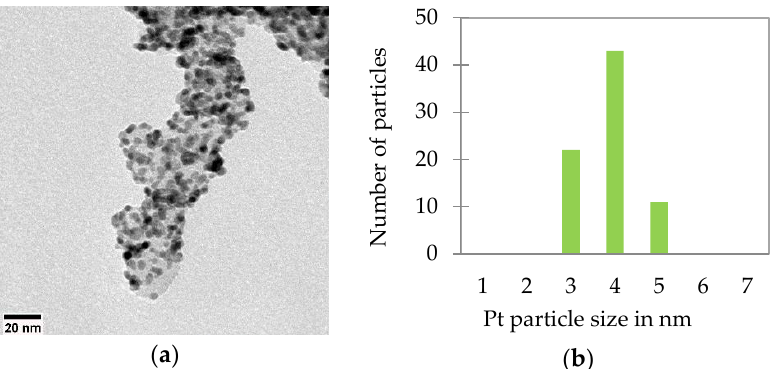
Figure 1. TEM image of a non-annealed 18.5 wt % Pt on CB supported synthesized catalyst ( a ) and distribution of Pt nanoparticle on the support ( b ).